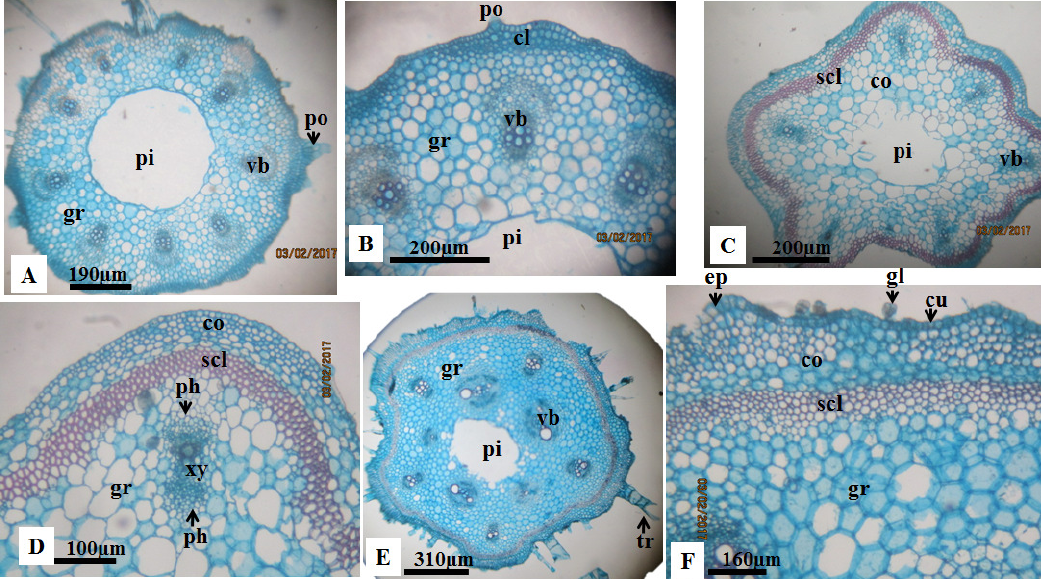
Fig. 6. Anatomy of stem of B. hispida (A and B), petiole (C and D) and Tendril (E and F) Abbreviations: vb = vascular bundle, pi = pith, cu = cuticle, ep = epidermis, po = papillose, co = cortex, gr = ground tissue, ph = phloem, xy = xylem, tr = trichome, scl =